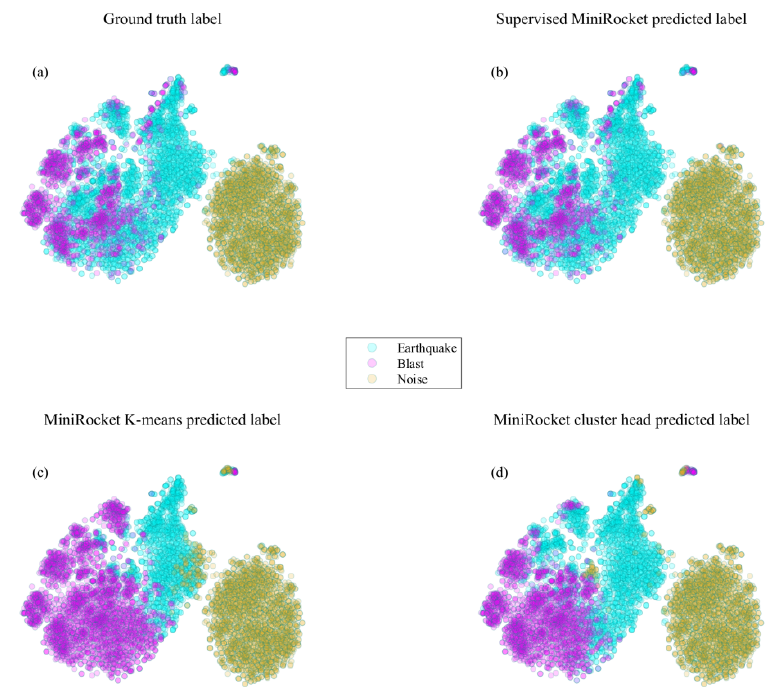
Figure 5. Visualization of feature extraction of three classification models based on MiniRocket.